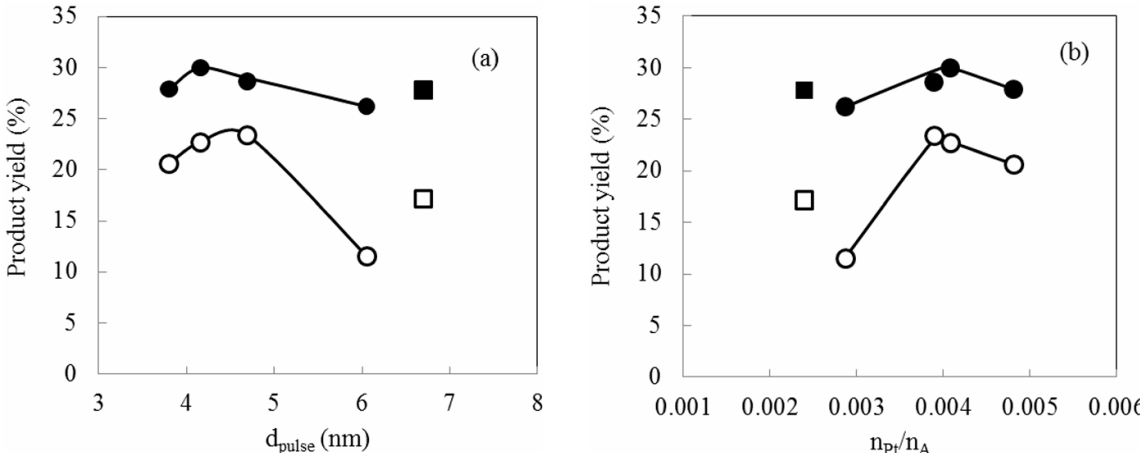
Figure 7. Effect of d pulse and n Pt / n A on product yield in hydrocracking of FT product over Pt-loaded zeolite catalysts. ● Y C9–C15 (Cat. A, C, D, E (M-Pt(X)/940HOA)) . ○ Y C1–C8 (Cat. A, C, D, E (M-Pt(X)/940HOA) ). ■ Y C9–C15 (Cat. J (I-Pt/940HOA)). □ Y C1–C8 (Cat. J